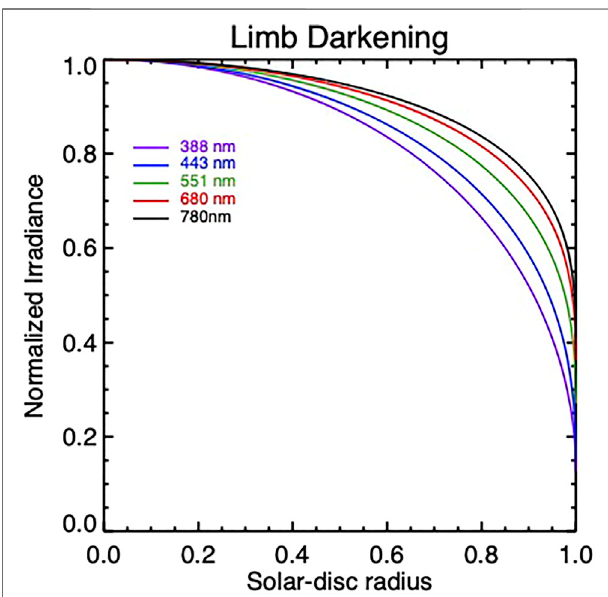
FIGURE 2 | Limb darkening function based on Neckel